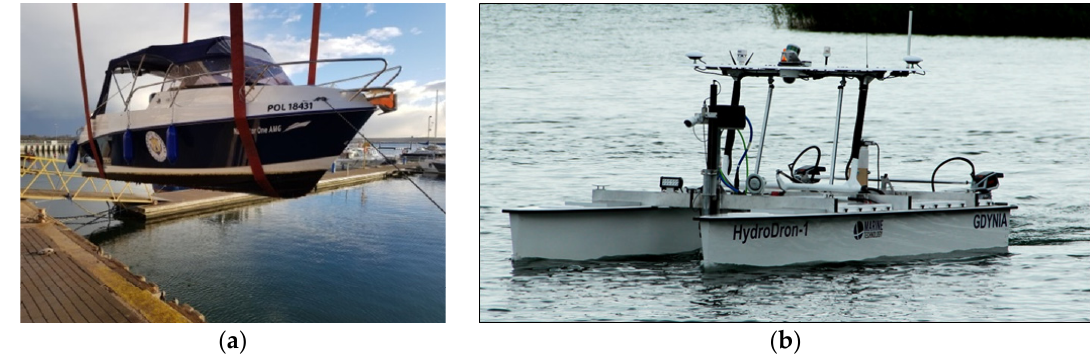
Figure 7. Hydrographic vessel with a draft of 30 cm ( a ) and unmanned surface vehicle (USV) designed for coastal measurements ( b ).